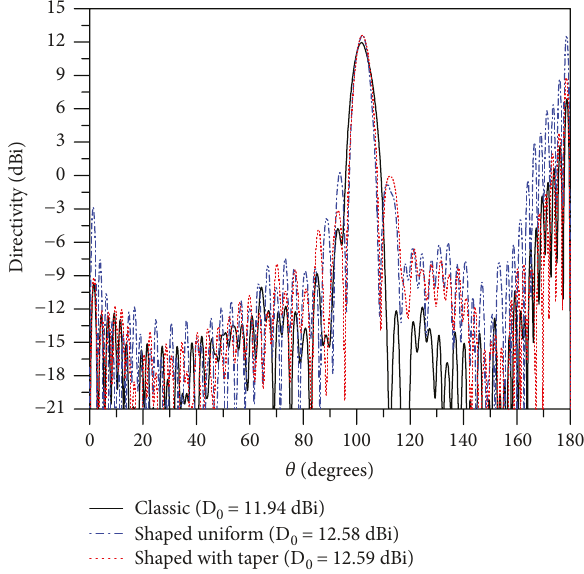
Figure 17: MoM/MMT radiation patterns of the classical and shaped ADC antennas.